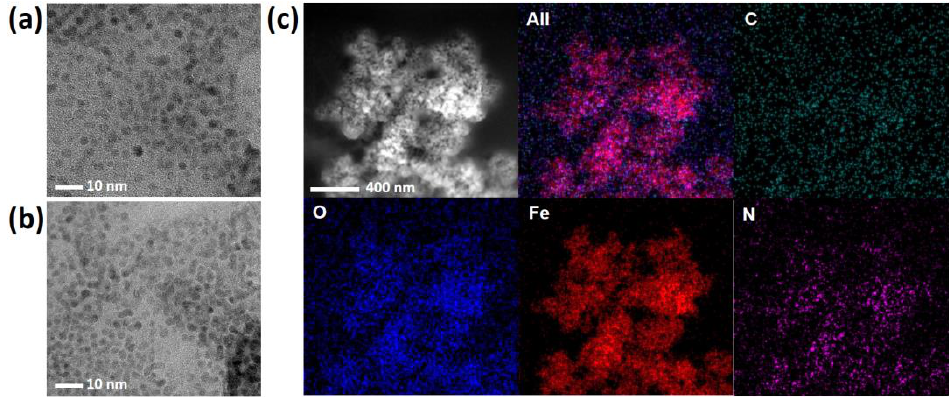
Figure 1. TEM analysis of ( a ) His@MNPs and ( b ) MNPs. ( c ) EDS analysis with the TEM images of His@MNPs.